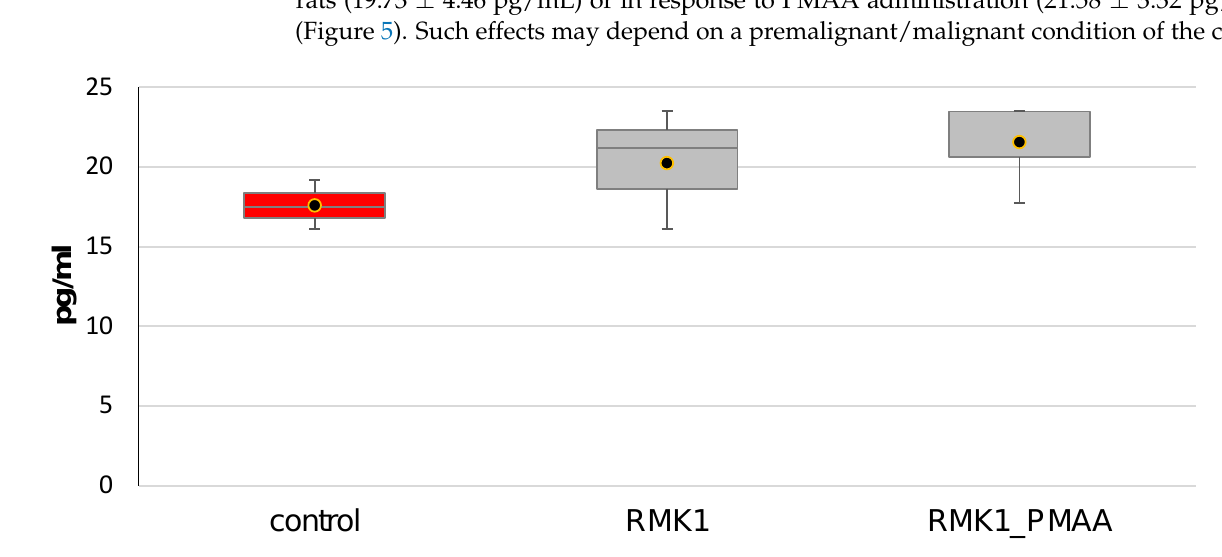
Figure 5. Changes in TNF- α concentrati on in response to PMAA administration.